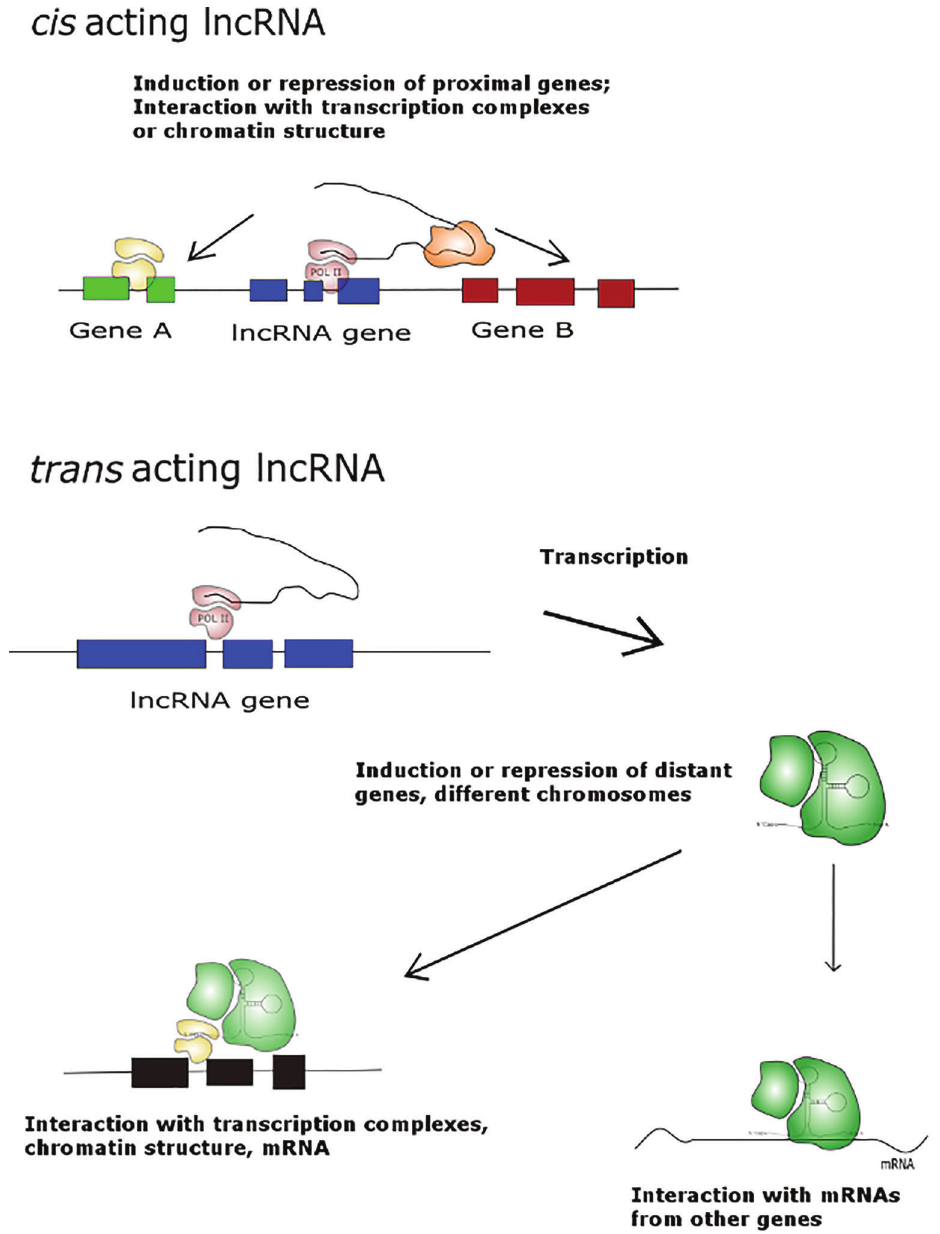
Figure 2. Mechanisms by which long non-coding RNAs (lncRNAs) can regulate gene